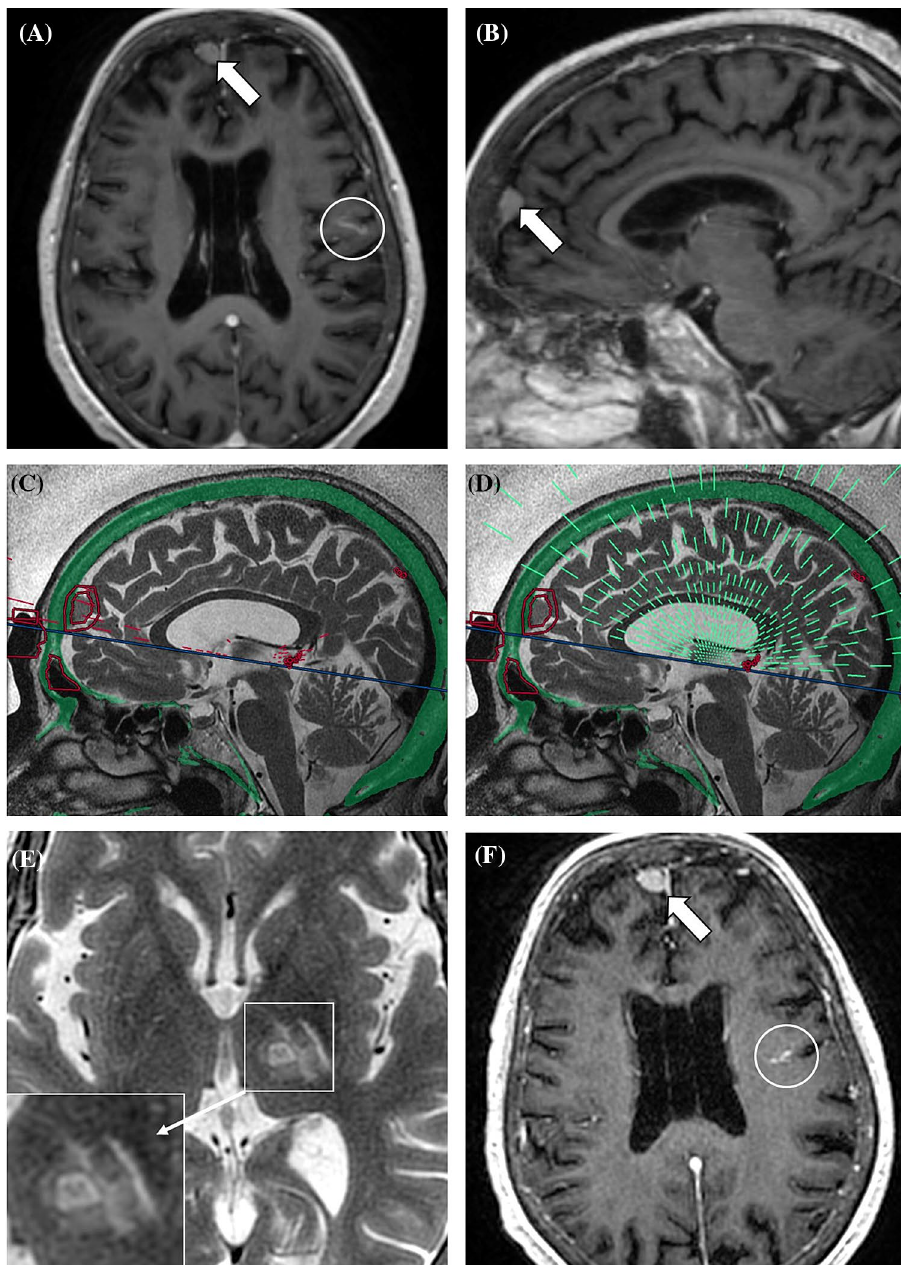
Figure 4. 81-year-old woman with essential tremor. Preoperative axial ( A ) and sagittal ( B ) multiplanar reconstructions (3 mm thick, average algorithm) from post-contrast T1w 3D BRAVO demonstrate a 11 mm extra-axial lesion compatible with meningioma (arrows). A developmental venous anomaly in the left fronto- parietal region is also present (white circle). Sagittal intraoperative T2-weighted FRFSE images show no-pass regions (red circles) with blocked [( C ) red lines] and active [( D ) green lines] elements. A total of 13 additional elements (11.6% of all blocked elements) were turned off due to the presence of the meningioma. 48-h follow-up axial T2-weighted FRFSE sequence ( E ) shows the FUS-placed lesion in the left nucleus ventralis intermedius. Post-contrast ( F ) image demonstrates no changes in the meningioma (arrow) or developmental venous anomaly (white